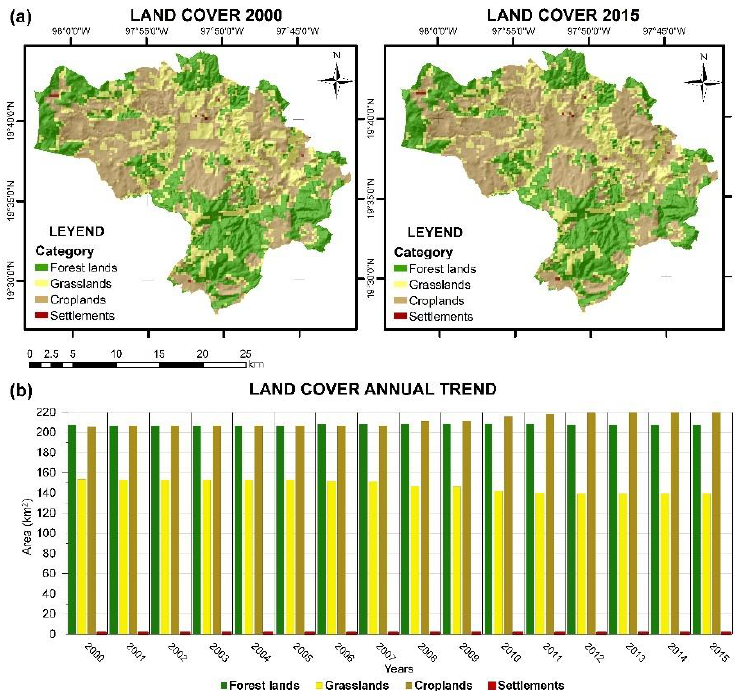
Figure 2. ( a ) Land Cover spatial distribution for 2000 and 2015 in Ixtacamaxtitlan, Puebla, México; ( b ) Annual trend of Land Cover categories for 2000 to 2015.